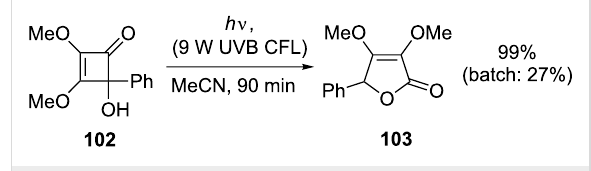
Scheme 35: Photochemical rearrangement of